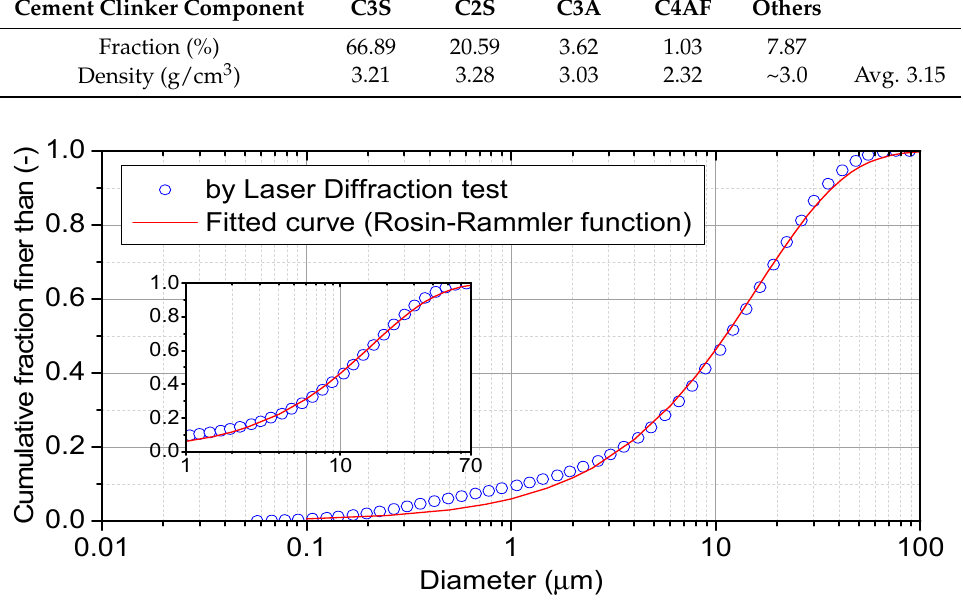
Figure 1. Particle Size Distribution (PSD) of the white cement and the fitted analytical curve.